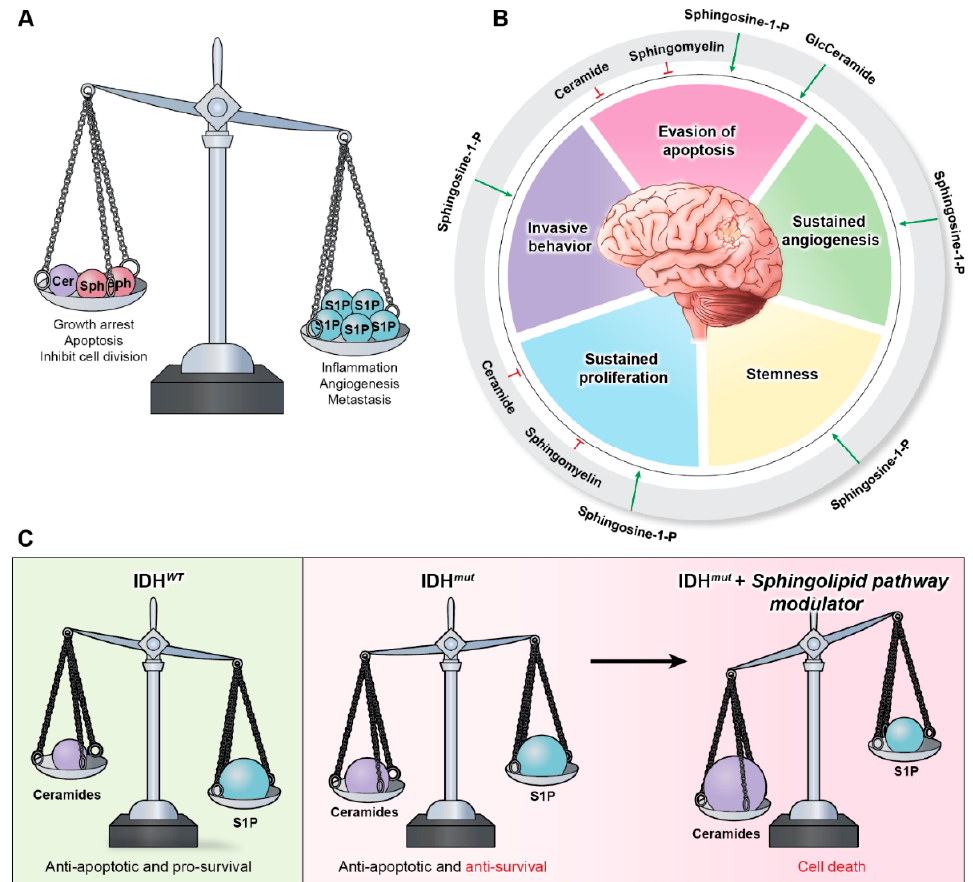
Figure 1. The interplay between ceramide and S1P forms the basis of the sphingolipid rheostat and is the focus of great interest because of its implications for the hallmarks of cancer. ( A ) Sphingolipid rheostat and how this balance can affect cell growth. ( B ) Key effects of significant sphingolipids on the hallmarks of cancer. ( C ) Vulnerabilities of the rheostat of IDH mut tumors make them susceptible to drugs that induce ceramide accumulation or S1P depletion. Therefore, sphingolipid pathway modulators may play a key role in altering the rheostat and diminishing the hallmarks of